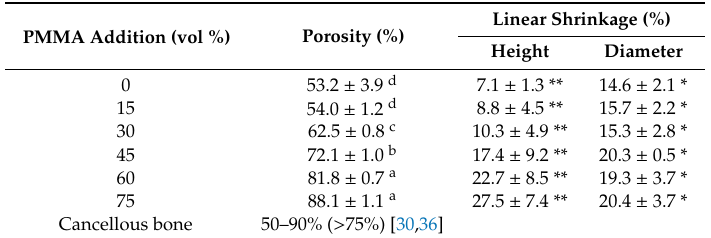
Table 2. Linear shrinkage for each diameter and height of the HA sca ff olds with respect to the PMMA addition amount ( n = 4)